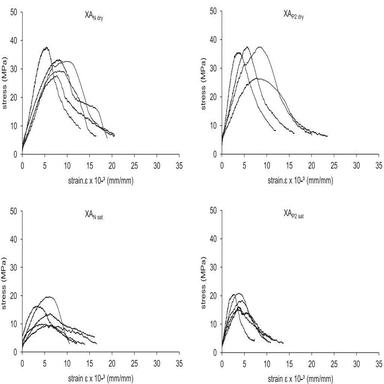
Stress–strain diagrams for XA schists tested under dry (above) and saturated (bellow) conditions.